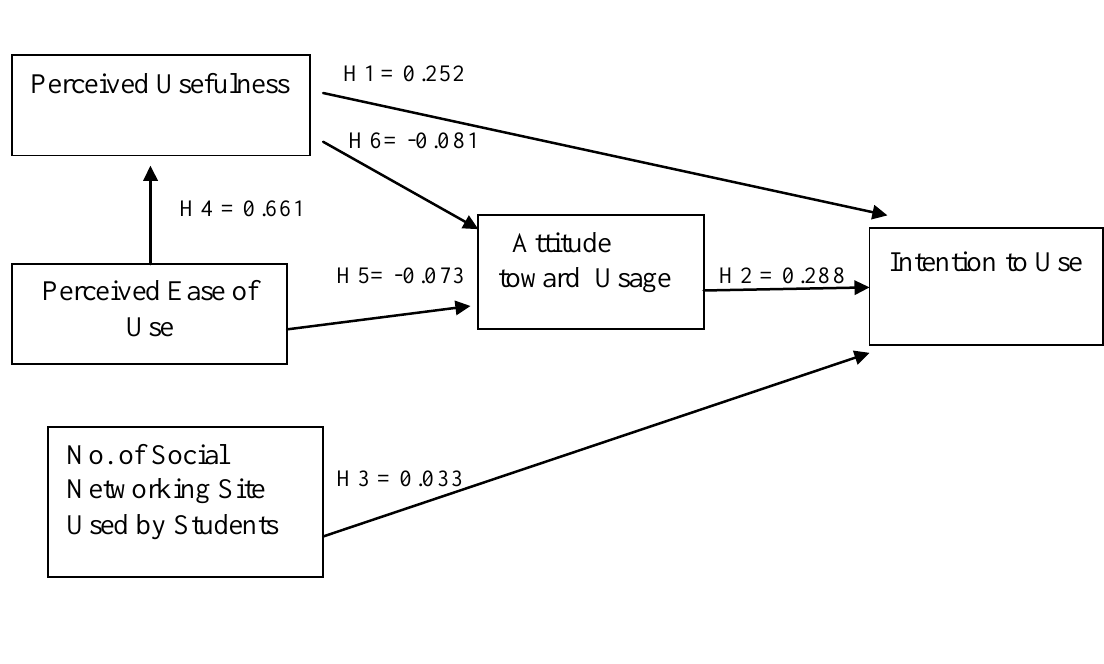
Figure 2. Path coefficient research model